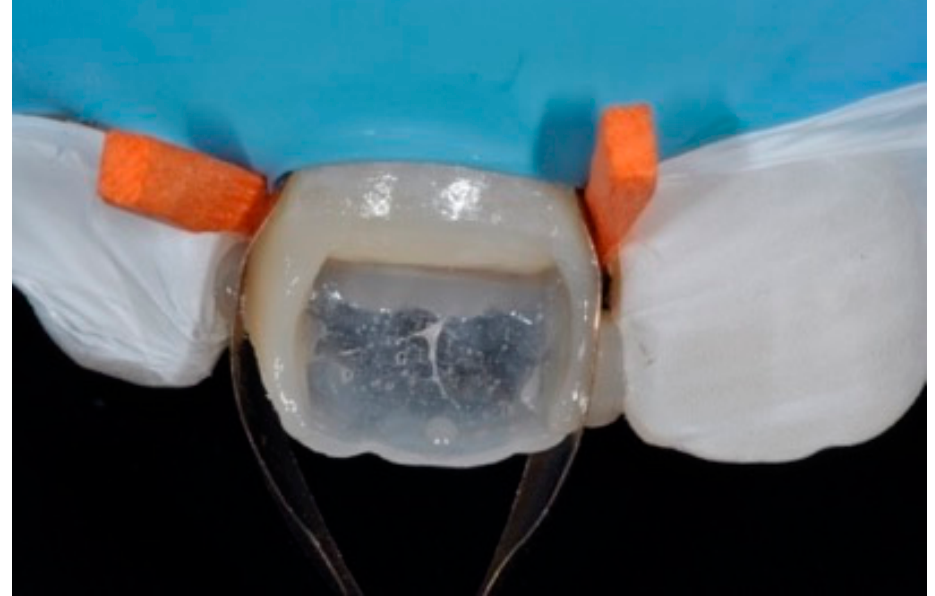
Figure 6. Sectional matrices applied and stabilized with wedges and flowable drops. Reprinted from Restauri diretti nei settori anteriori, G. Paolone, S. Scolavino, © 2021, with permission from Quintessence Publishing Italy.